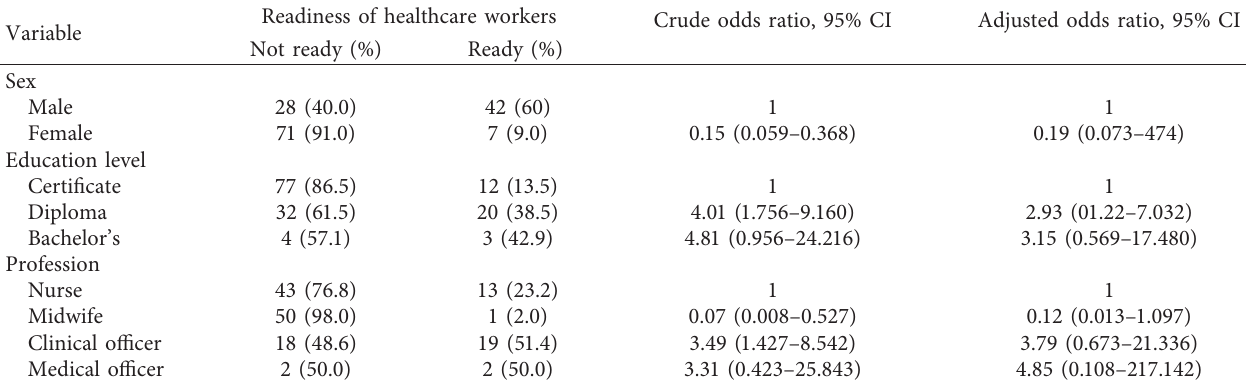
Table 7: Multivariable analysis for the association between sociodemographic factors and